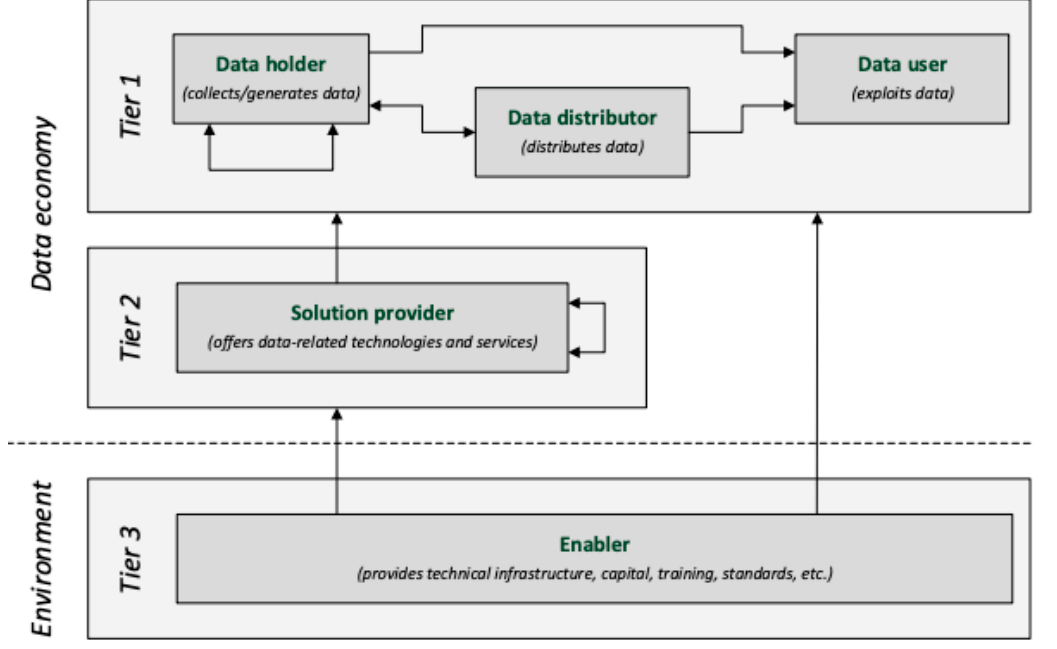
Figure 7. Data economy population. Reproduced from reference [18], with permission from European Union, 2017.